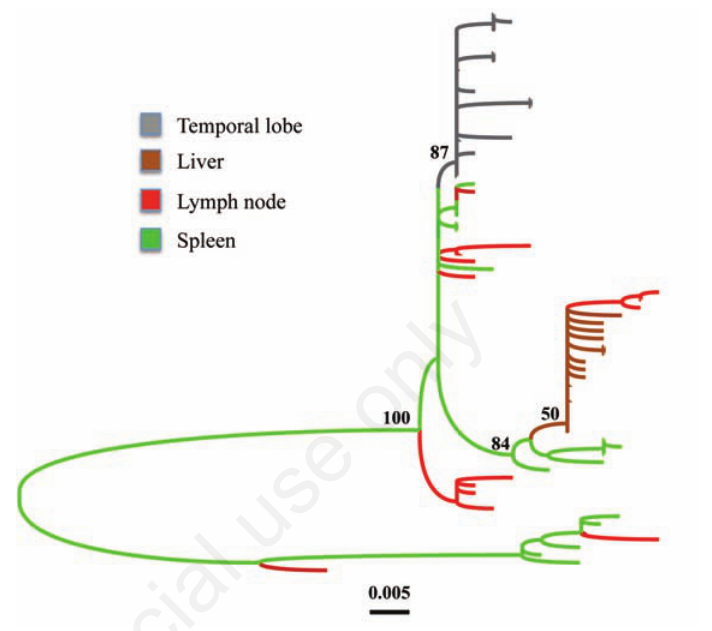
Figure 2. Maximum likelihood genealogy of HIV-1 gp120 V3C4 sequences amplified from necropsy tissues of a patient with widespread atherosclerosis. The tree includes a subset of the sequences obtained from subject AZ described in Lamers et al . 65 (2011), and was inferred using the HKY+G model. Branch lengths are scaled in nucleotide substitu- tions per site according to the bar at the bottom and colored to highlight the tissue of ori- gin according to the legend in the figure. The tissue of origin of the internal branches was inferred by maximum parsimonious reconstruction of ancestral states. Numbers along the branches represent percent bootstrap values (1000 replicates). The alignment used in the analysis is available from the author upon request.